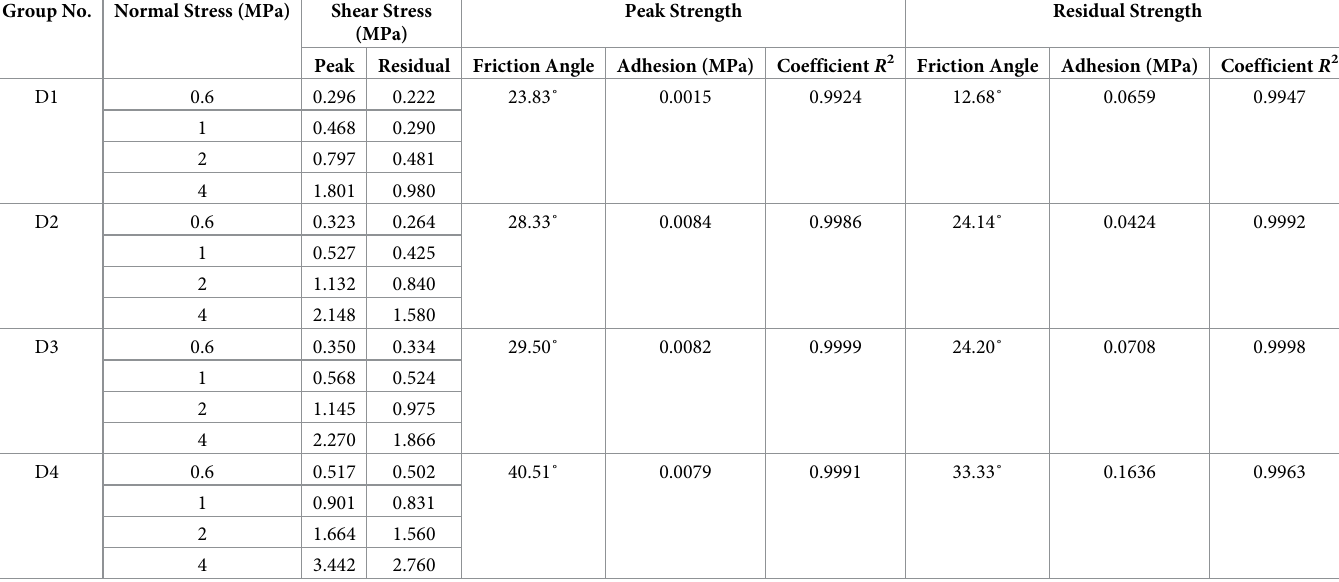
Table 4. Details and results of the direct shear